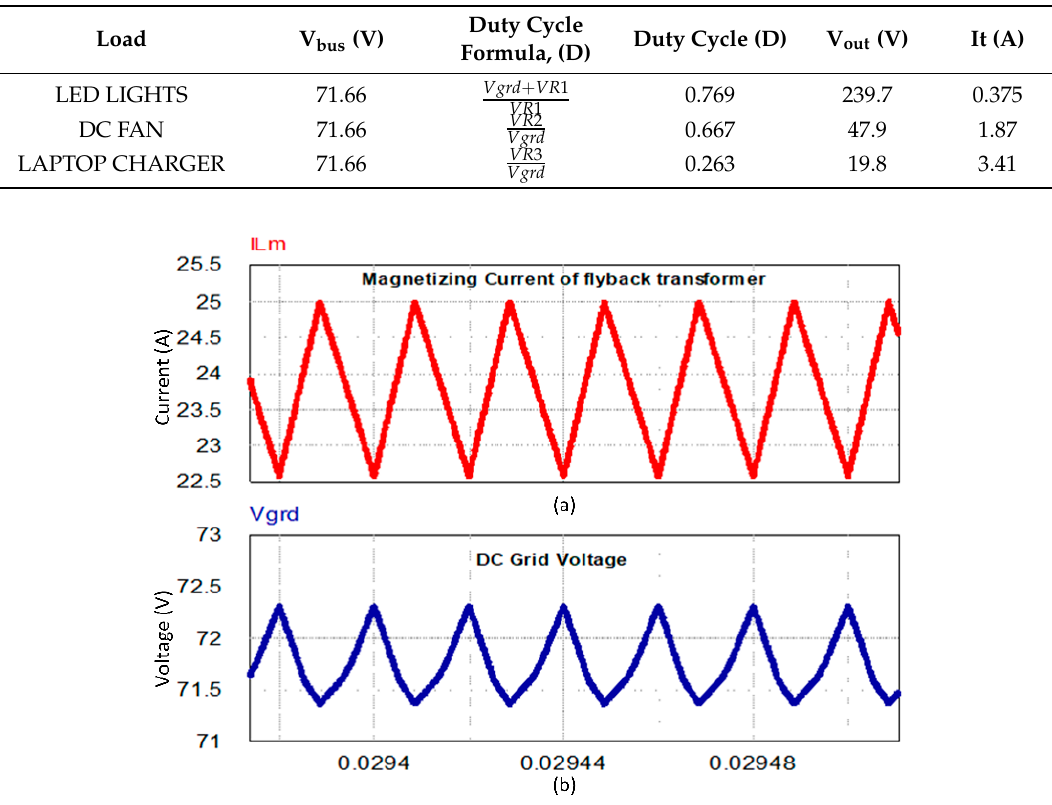
Table 3. Output voltages and currents of each load.